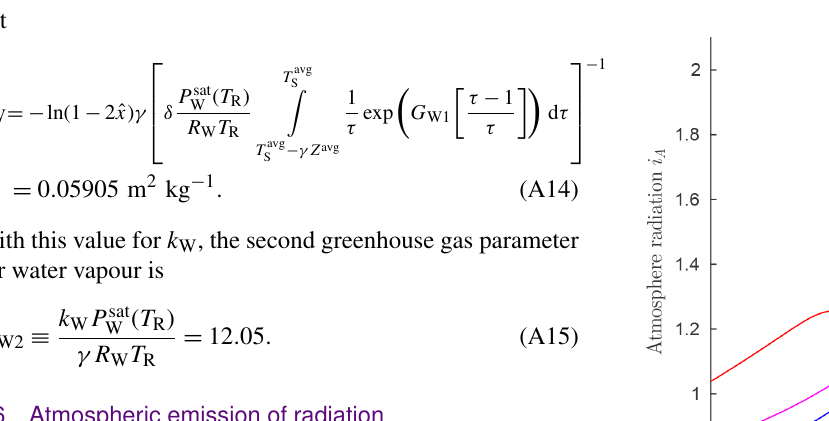
historical data gives low estimates in the 1.5 to 3 ◦ C range, while nonlinear models give higher